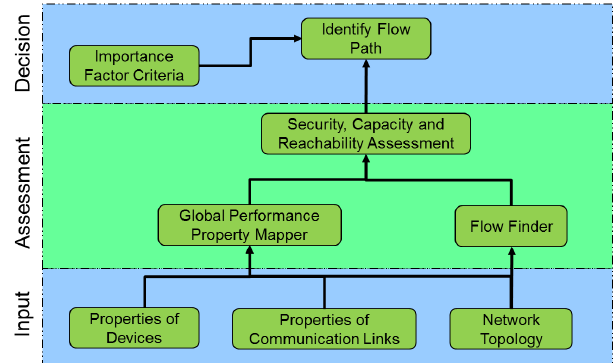
Figure 1. Architecture for Secure and Robust Path